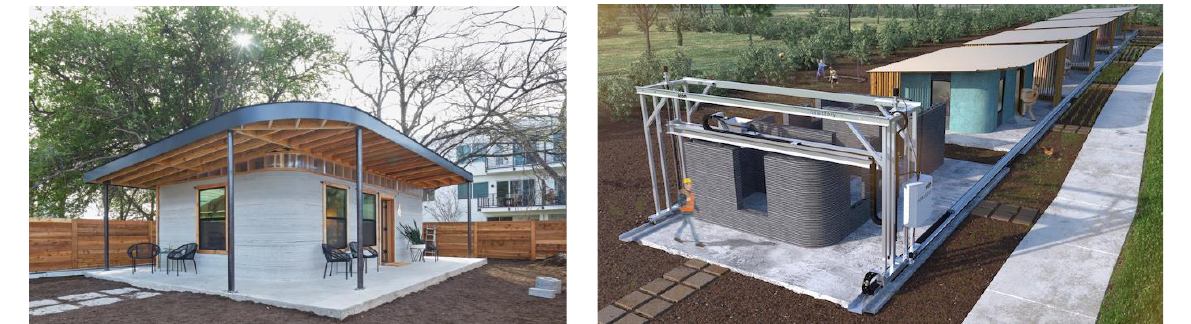
Source: themanufacturer.com